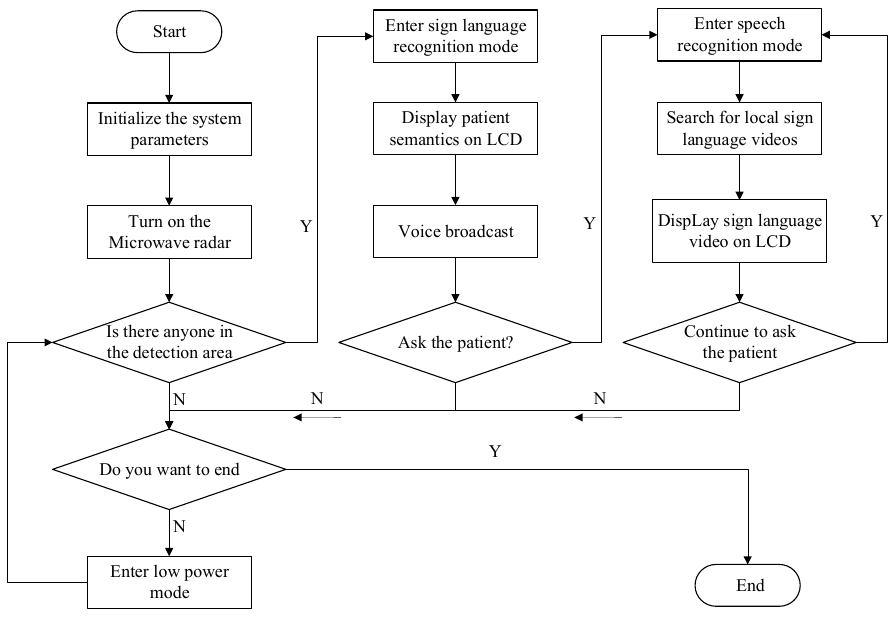
Figure 2. The flow chart of the main control.